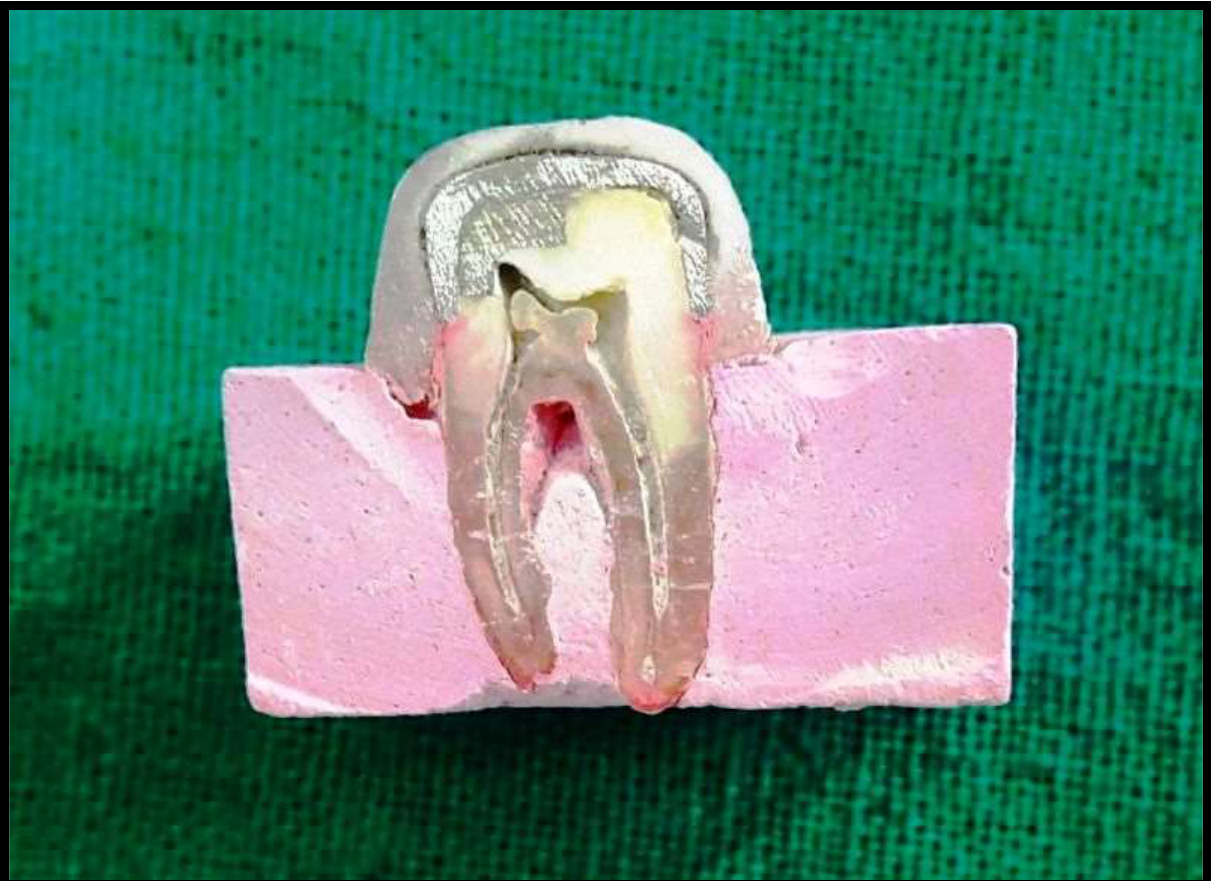
Figure 3. Tooth sectioned mesiodistally using precision cutting